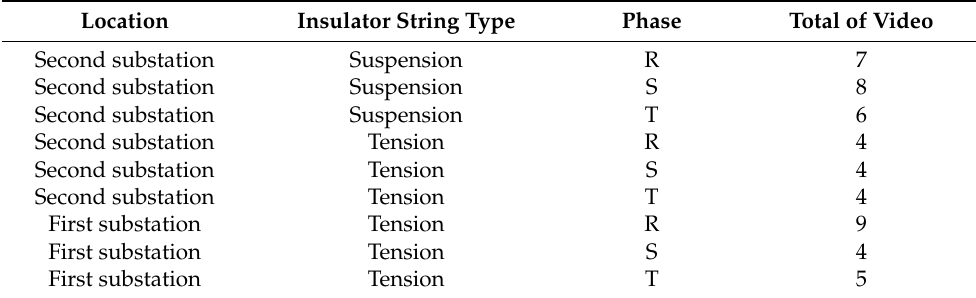
Table 2. The object of research for field